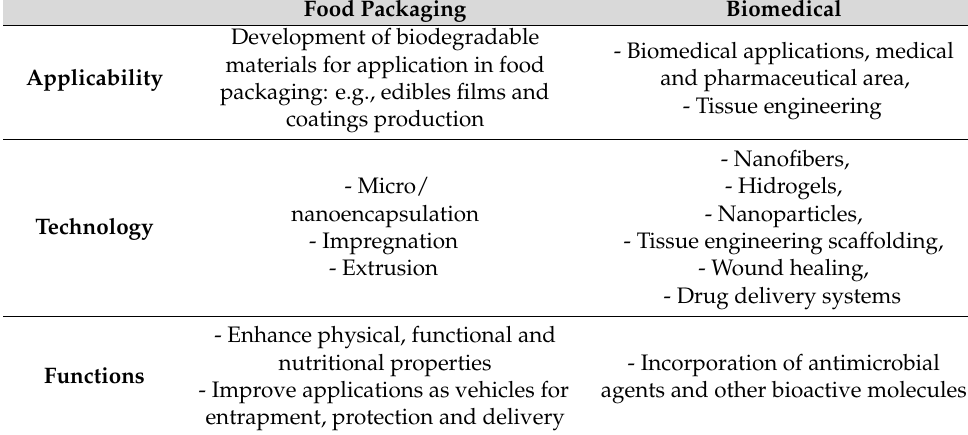
Table 4. Application of protein derived from dairy by-products to several industries. Food